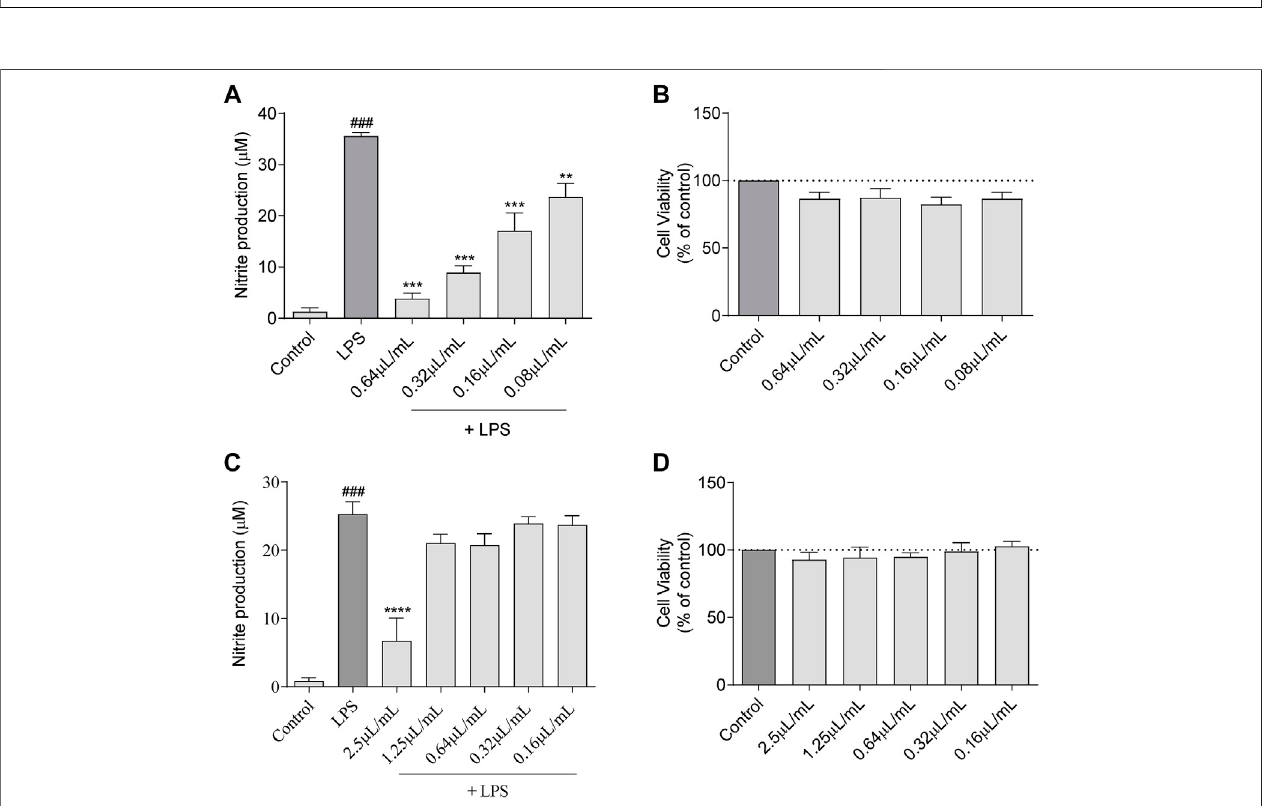
FIGURE2| NOproduction: (A) Effectof L.viridis L´Hér.essentialoil(EO)onnitriteproduction. (B) Effectof L.viridis L´Hér.essentialoilonmacrophagesviability. (C) Effectof1,8-cineoleonnitriteproduction. (D) Effectof1,8-cineoleonmacrophagesviability.CellviabilityisexpressedasapercentageofMTTreductionincomparisonto control cells (100% viability). Each value represents the mean ± SEM from at least three experiments, performed in duplicate. Statistical differences between control and LPS groups were calculated using two-sided unpaired t -test and differences between a treatment condition and LPS was performed using one-way ANOVA followed by Dunnet ’ s post hoc test (### p < 0.001, compared to control; ** p < 0.01, *** p < 0.001, **** p < 0.0001 compared to